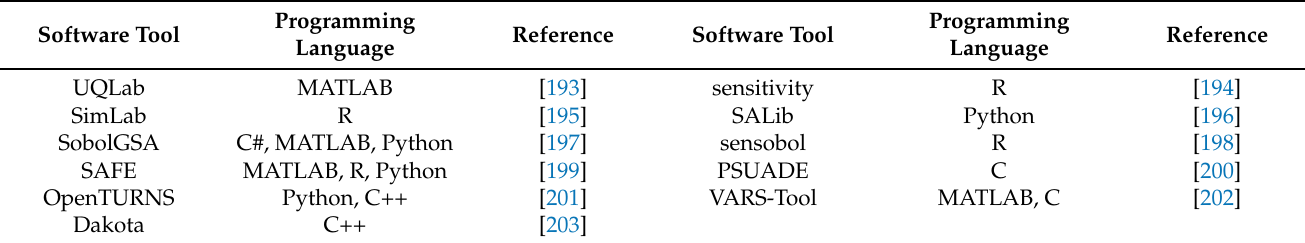
Table 4. Available computer packages for executing SA, with details on the programming language and original references. Software